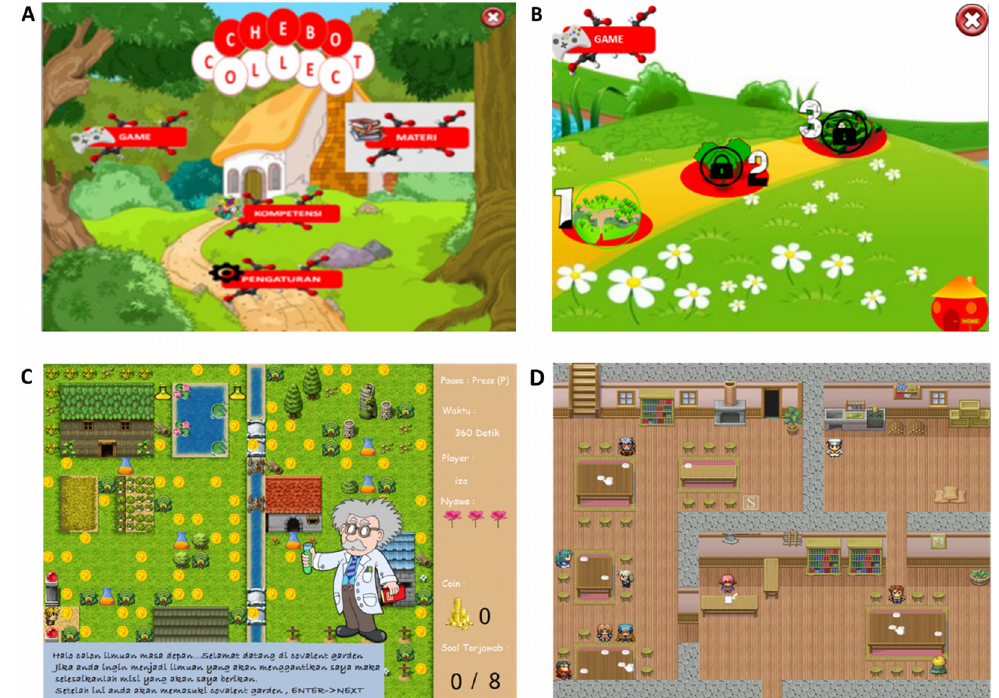
Figure 1. The Chebo collect game design. A. Main menu. B. Level select. C. Level 1, the gardens.